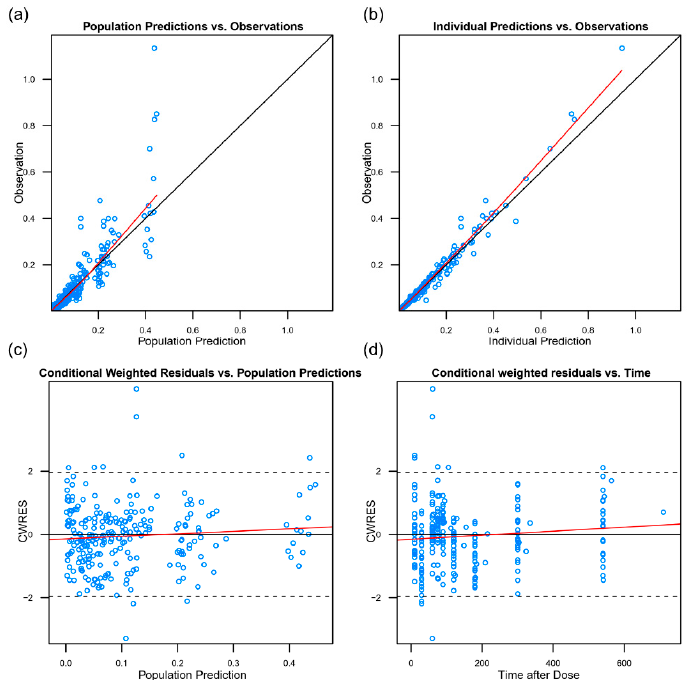
Figure 2. The goodness-of-fit plots for the population pharmacokinetic model. ( a ) The observed concentration vs. the population predicted concentration; ( b ) the observed concentration vs. the individual predicted concentration; ( c ) the individual weighted residual vs. the individual predicted concentration; ( d ) the weighted residuals vs. the time. The black lines = the line of identity in ( a ) and ( b ) and the line y = 0 in ( c ) and ( d ). The red line = smooth line with locally weighted regression.